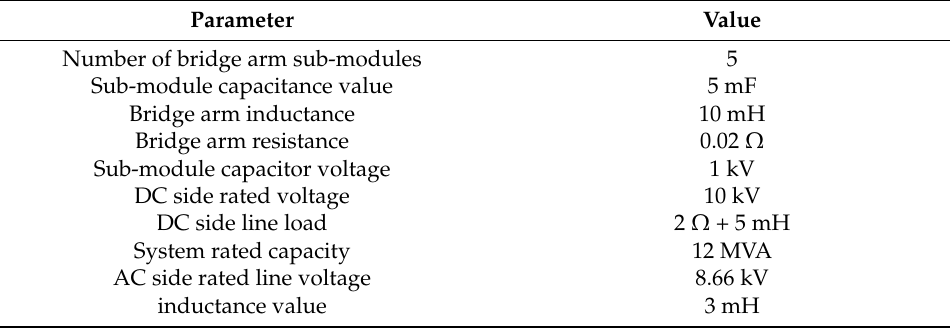
Figure 8. Simulation model structure diagram. Table 3. Simulation system parameters.